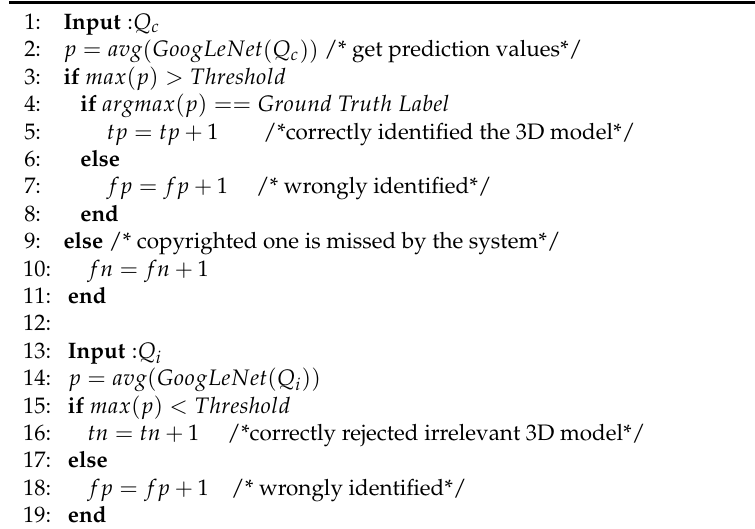
Figure 5. Graph of 3D model identification results with default settings and different thresholds. Table 1. Pseudo code for evaluating the performance of 3D model identification.